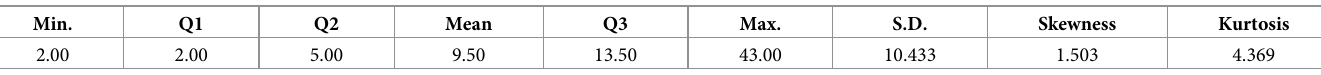
Fig 6. Estimated pdf and P-P plot of W-TEXPD, Weibull, Gamma, Exponential and TEXPD models. https://doi.org/10.1371/journal.pone.0249001.g006 Table 14. Descriptive statistics of 40 losses due to wind-related catastrophes.